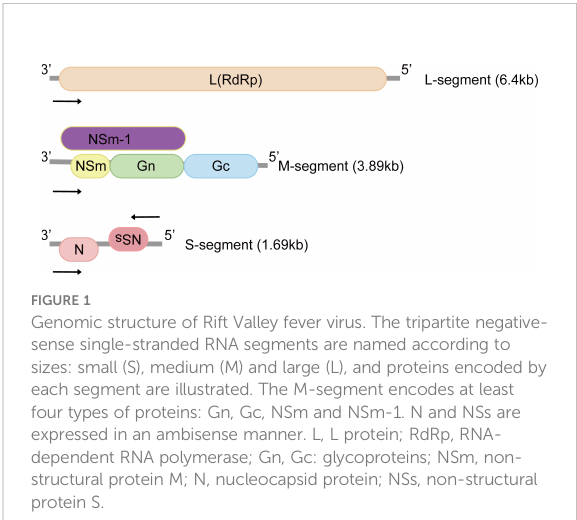
FIGURE 1 Genomic structure of Rift Valley fever virus. The tripartite negative- sense single-stranded RNA segments are named according to sizes: small (S), medium (M) and large (L), and proteins encoded by each segment are illustrated. The M-segment encodes at least four types of proteins: Gn, Gc, NSm and NSm-1. N and NSs are expressed in an ambisense manner. L, L protein; RdRp, RNA- dependent RNA polymerase; Gn, Gc: glycoproteins; NSm, non- structural protein M; N, nucleocapsid protein; NSs, non-structural protein